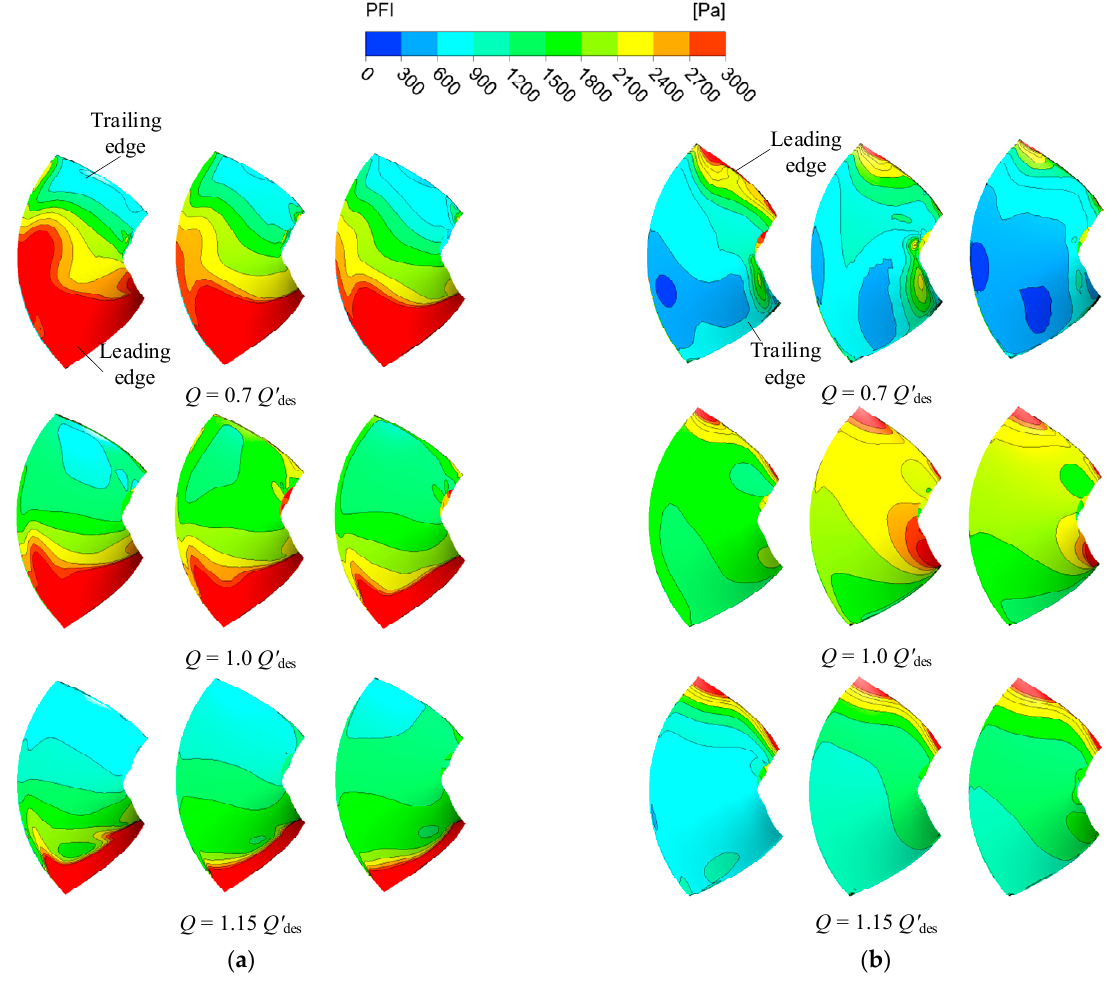
Figure 14. The distribution of PFI on ( a ) suction side and ( b ) pressure side of three kinds of blade under reverse condition.